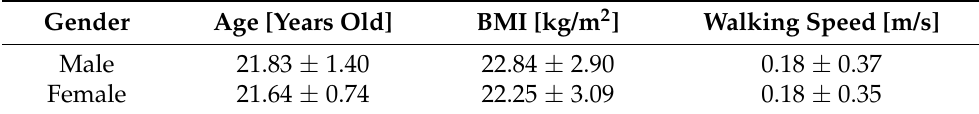
Table 2. Summary of participants’ descriptive data (M ± SD). BMI, body mass